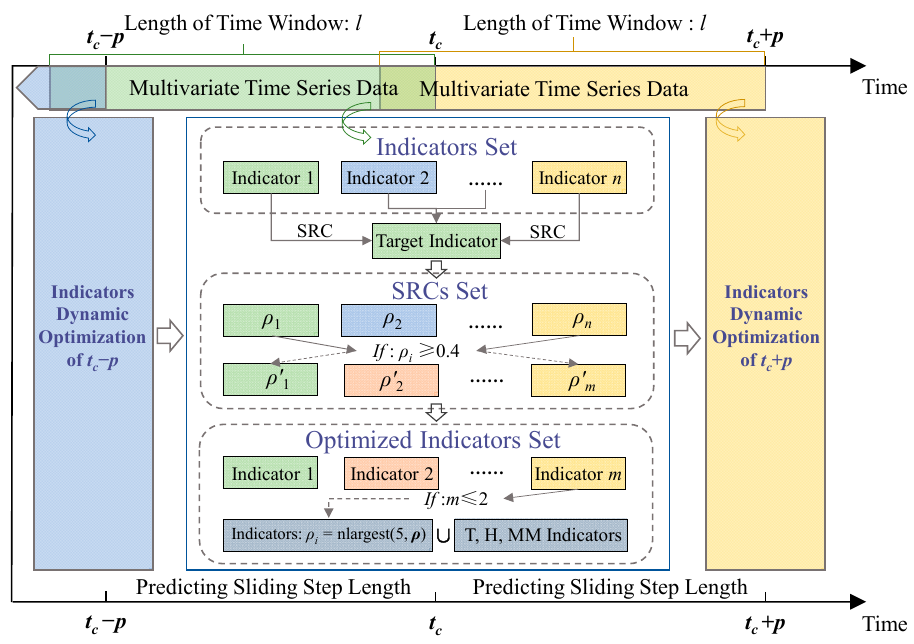
Figure 7. A dynamic optimization method for prediction indicators based on SRC.